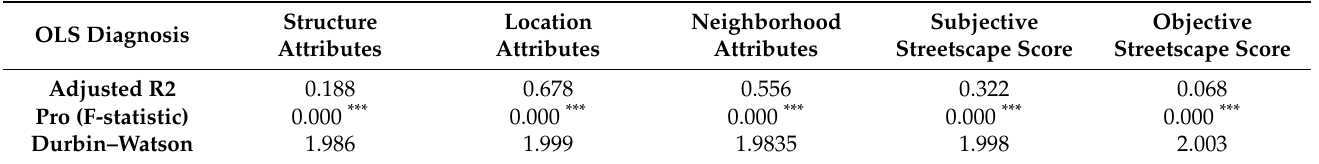
Table 6. Model performance with different groups of